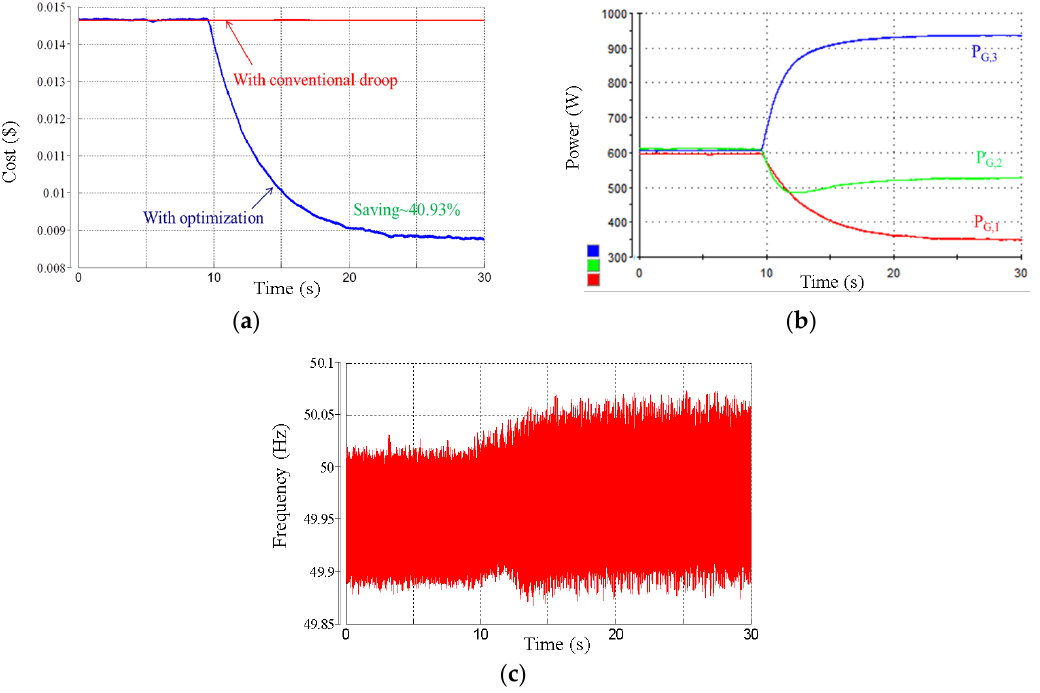
Figure 13. Experimental results of comparison between conventional droop and optimization. ( a ) operation cost; ( b ) real power; and ( c ) frequency given.